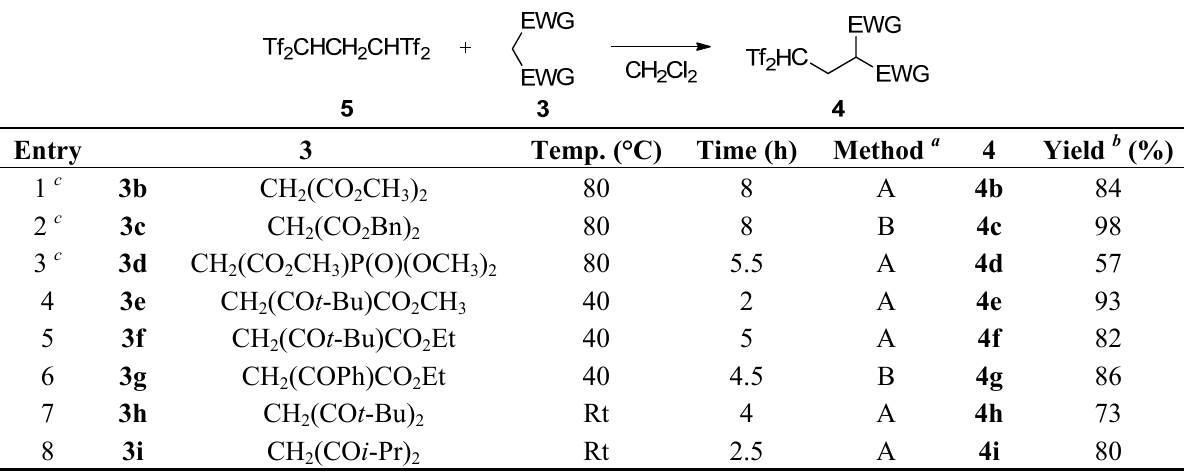
CHCH CHTf 5 with 1,3-dicarbonyl compound 3 2 2 2